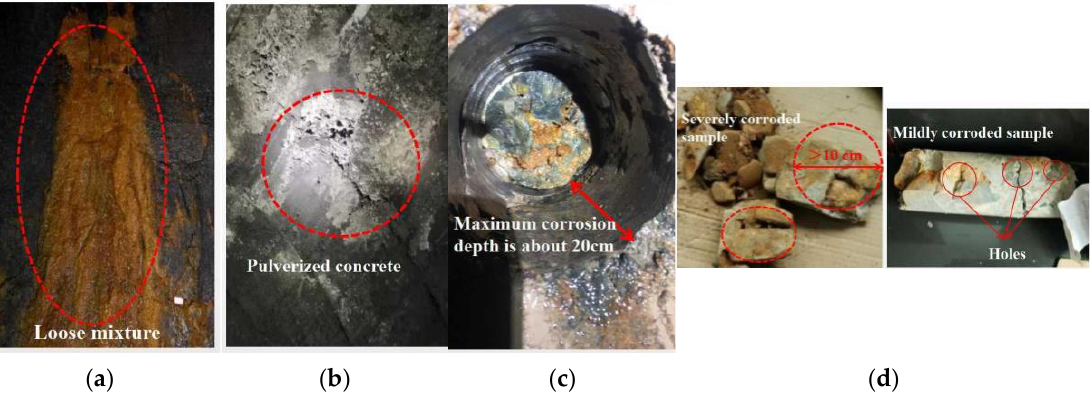
Figure 1. Investigation of HTG tunnel lining corrosion. ( a ) Salt attachment; ( b ) Pulverized surface concrete; ( c ) Measured corrosion depth; ( d ) Drill core sample.